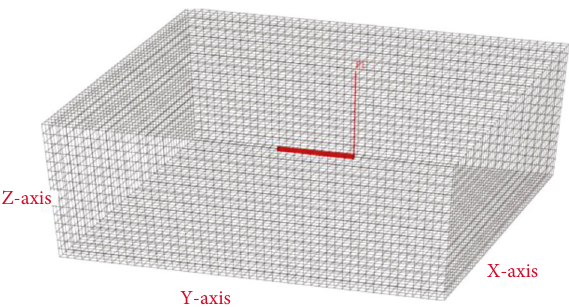
Figure 1: Schematic diagram of physical model of a horizontal well in three-dimensional box-like reservoir.